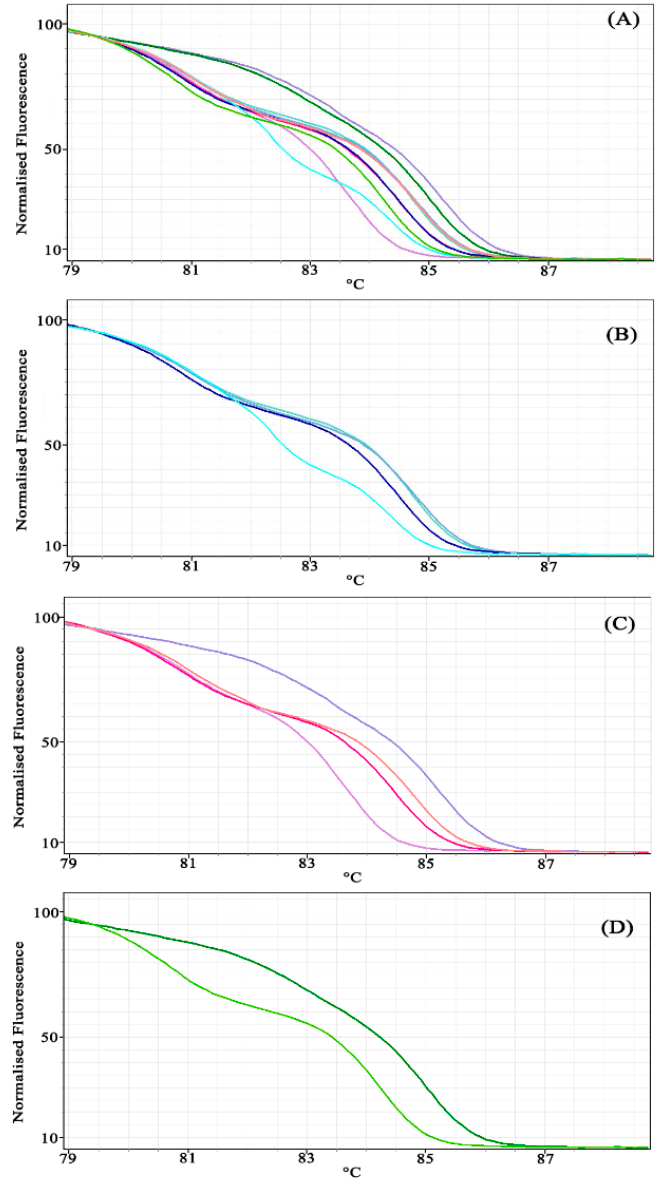
Figure 3. Melting profiles of 10 Dipterocarpaceae species generating from HRM analysis using M1 primers ( rbcL ). Normalised curves of ( A ) all 10 species; ( B ) species from genus Dipterocarpus ; ( C ) species from genus Shorea ; ( D ) species from genus Hopea .